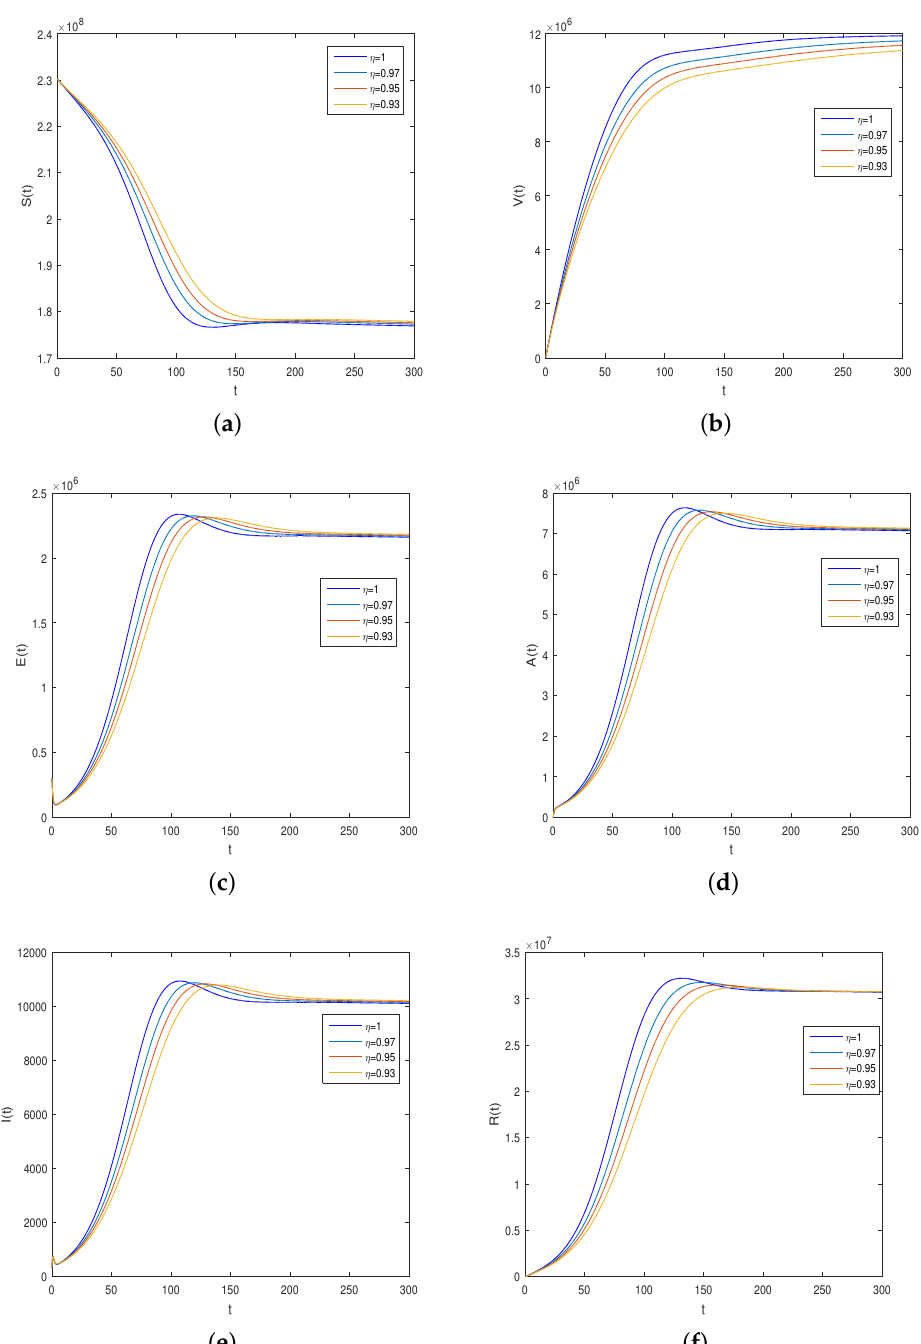
Figure 3. Simulation of model (3) under various values of the fractional order η . Subfigures ( a – f ) de- scribes the dynamics of susceptible, vaccinated, exposed, asymptomatic, symptomatic, and recovered individuals